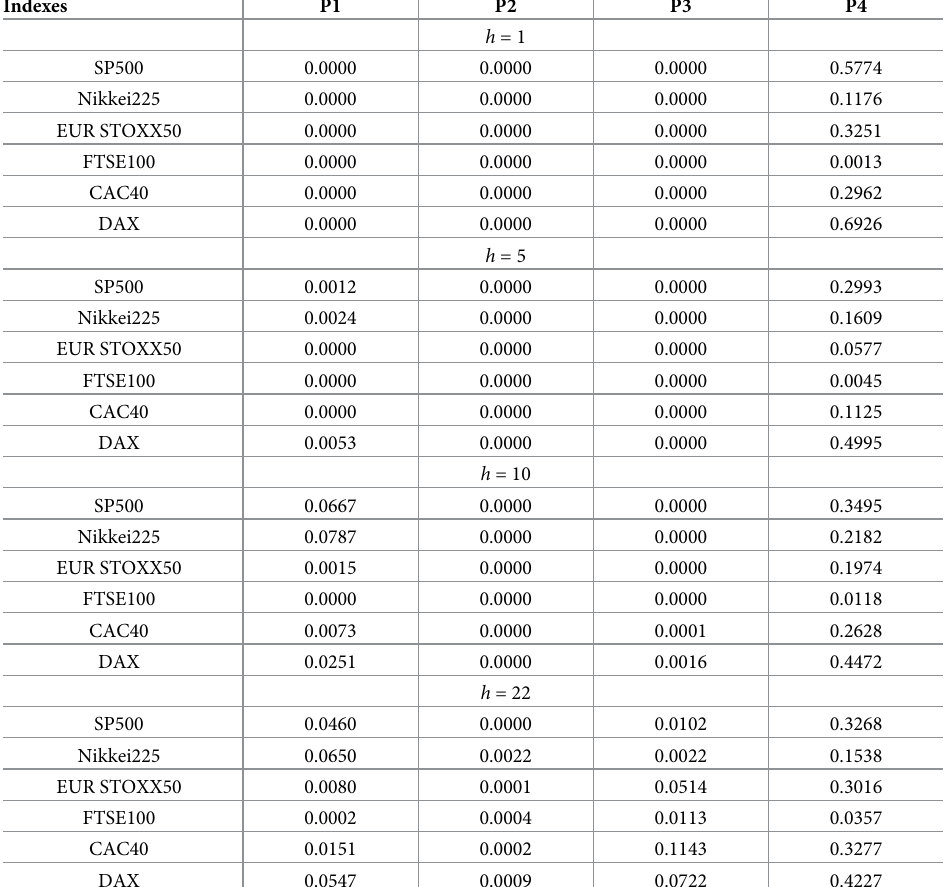
Table 9. Out-of-sample forecasts performance comparations of LHAR, LHARO, LHARV and LHAROV based on rolling window with 2000 out-of-sample